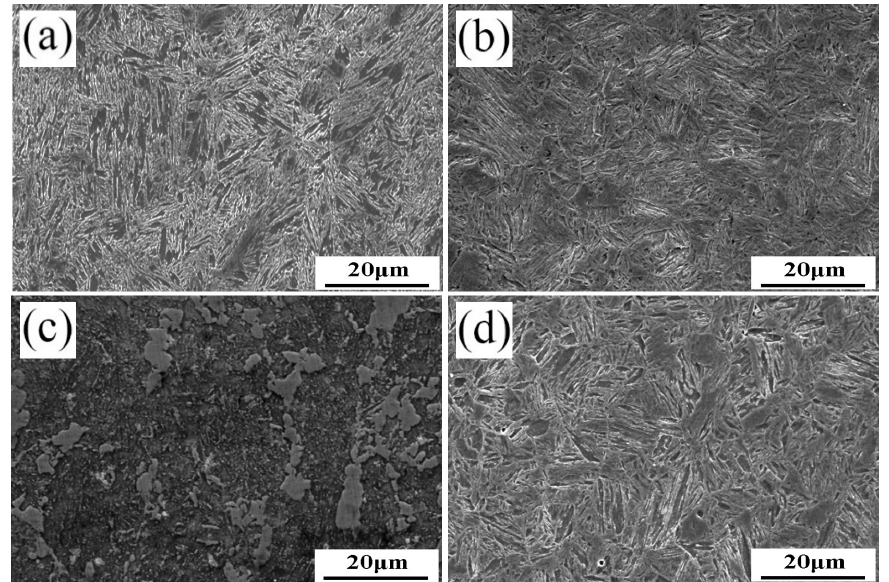
Figure 12. SEM micrographs of two investigated steels after heating for 5 min. ( a ) 22Mn3SiNb, 750 °C, ( b ) 22Mn3SiNb, 800 °C, ( c ) 22MnB5, 800 °C, ( d ) 22MnB5, 900 °C.